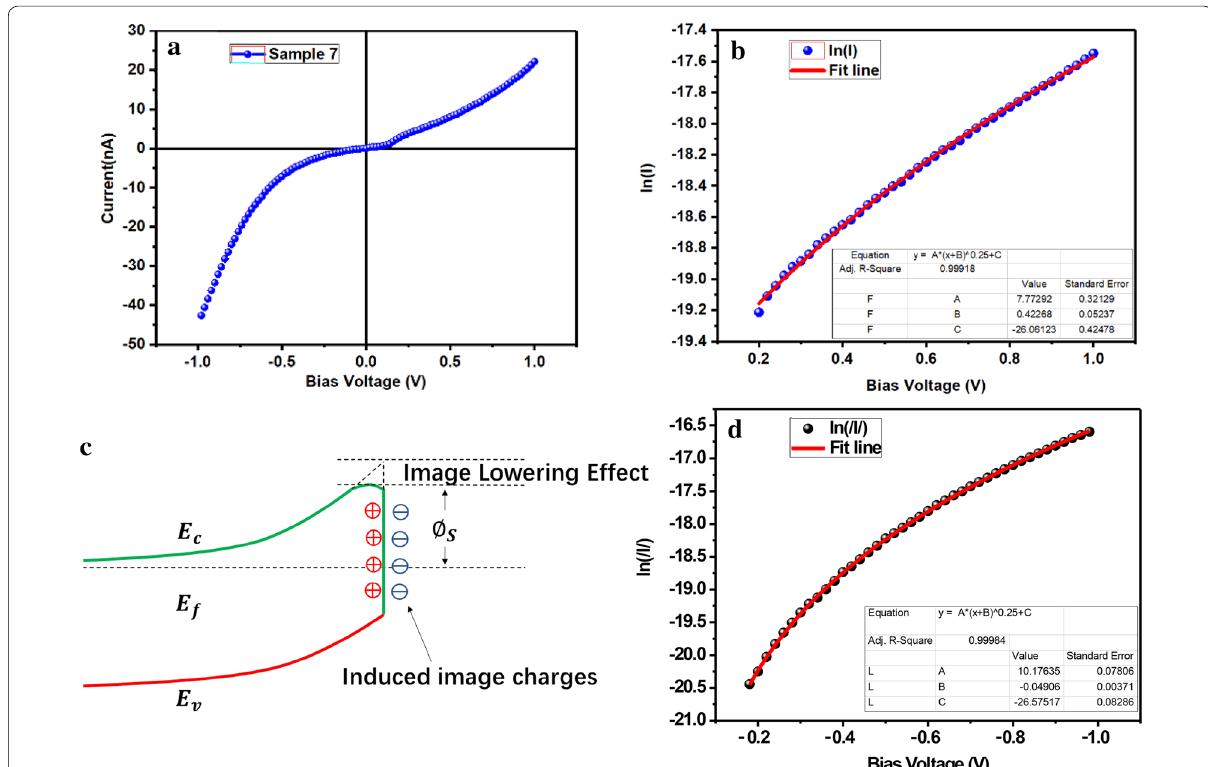
Fig. 5 a Electrical characteristics of sample 7, fitting the b positive part and d negative part of electrical curve of sample 7 with Eq. (10), c Energy band diagram considering the image